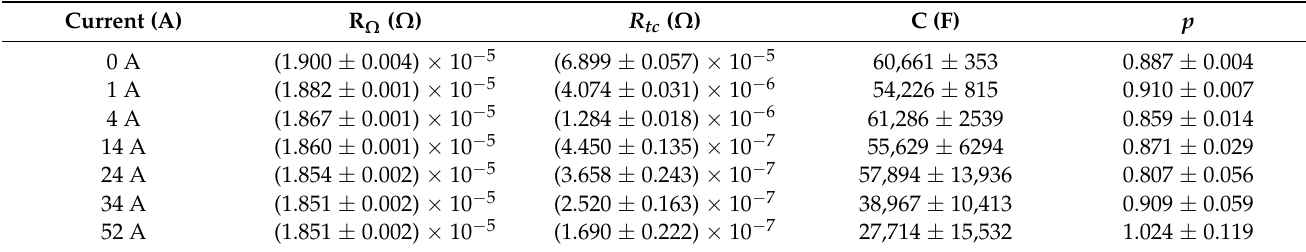
Table 3. Ohmic resistance ( R Ω ), charge transfer resistance ( R tc ), and capacitance ( T ) and phase exponent ( p ) fitting values of filter EIS curves. Equation